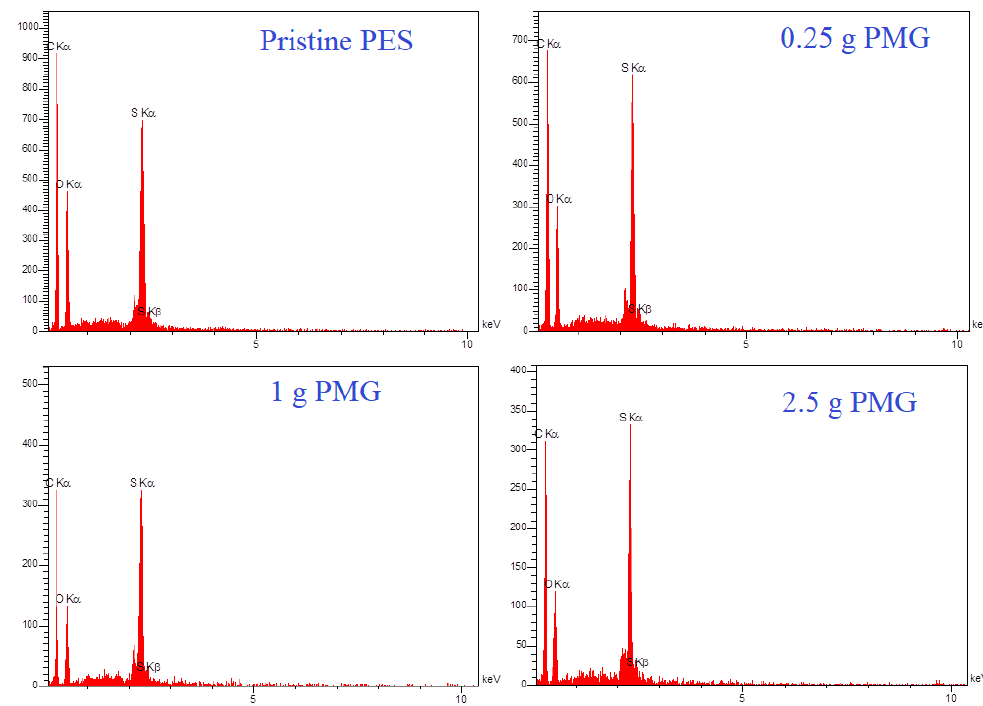
Figure 9. EDX of the membranes prepared form different PMG contents.